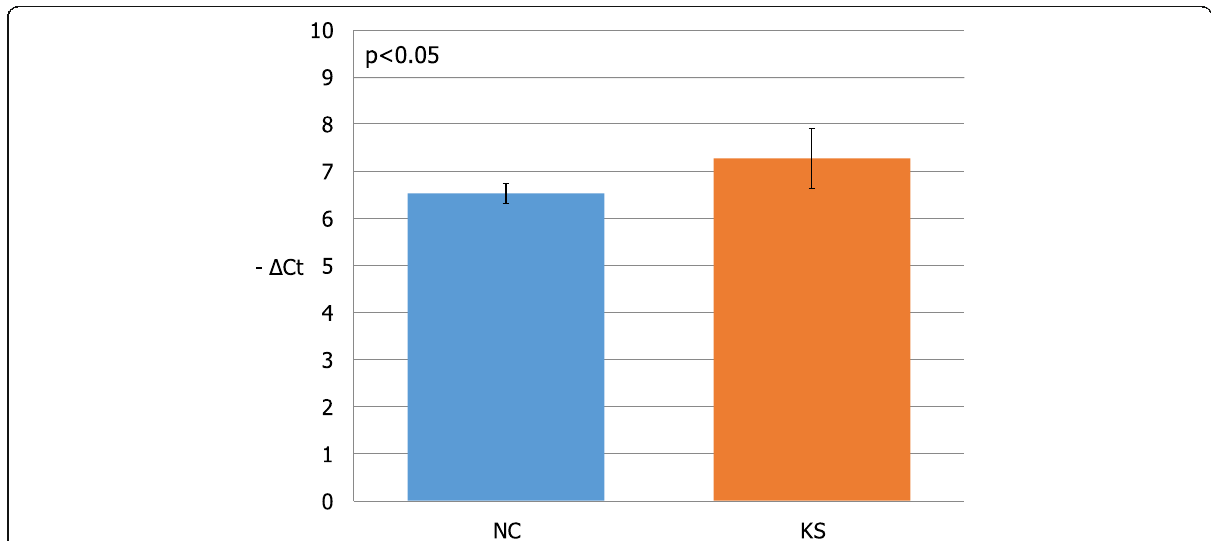
Fig. 3 Mean of lncRNA GAS5 expression values in patients with Klinefelter syndrome and normal controls. KS, Klinefelter syndrome; NC, normal